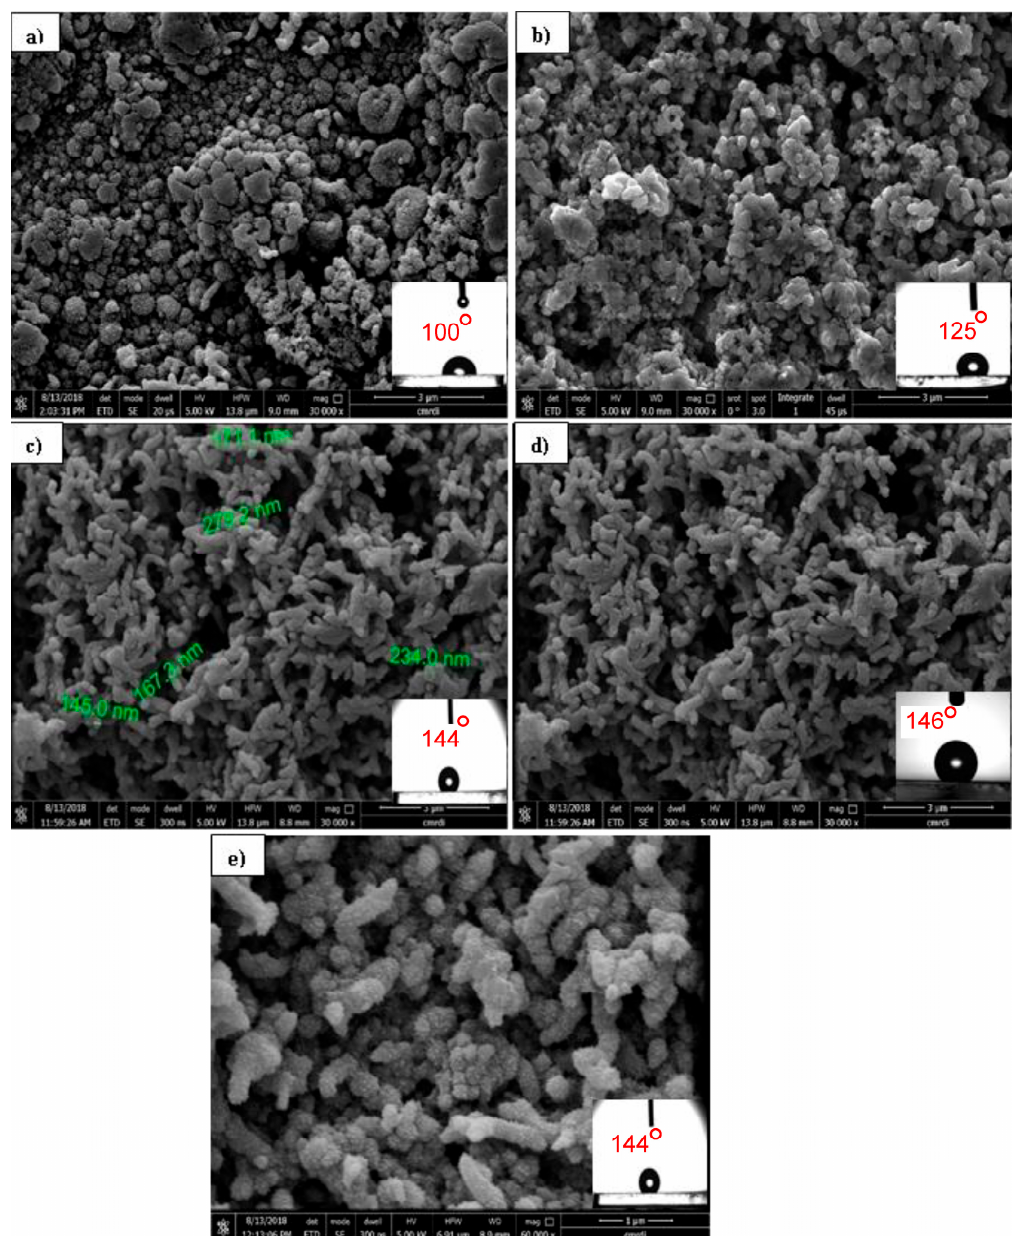
Figure 11. FE-SEM images of PANI/TiO 2 composites with different TiO 2 concentrations: ( a ) 0.03 g/L, ( b ) 0.125 g/L, ( c ) 0.225 g/L, and ( d ) 0.4 g/L at 30 cycles. ( e ) Higher magnification of ( c ). FE-SEM images show the water drop CAs imbedded on the respective surfaces (100°, 125°, 144°, and 146° for ( a ), ( b ), ( c ) and ( d ), respectively).